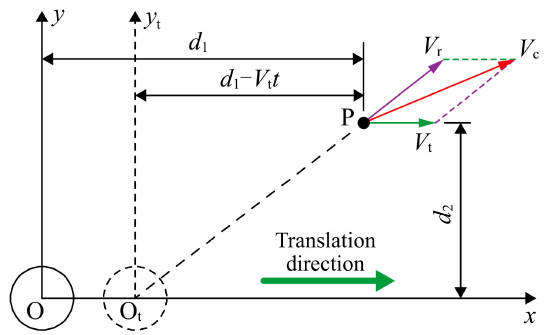
Figure 1. Vector synthesis of the downburst’s radial speed and translation